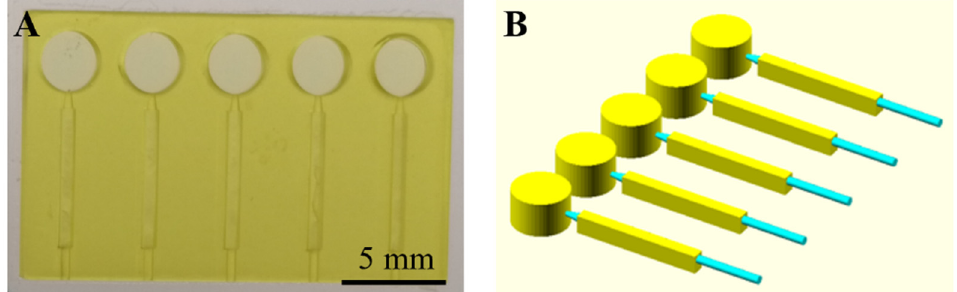
Figure 3. Optimized 3D-printed microfluidic prototype (Device 15) for plasma separation. ( A ) Top view image of the final device. ( B ) CAD design of the separated channels.